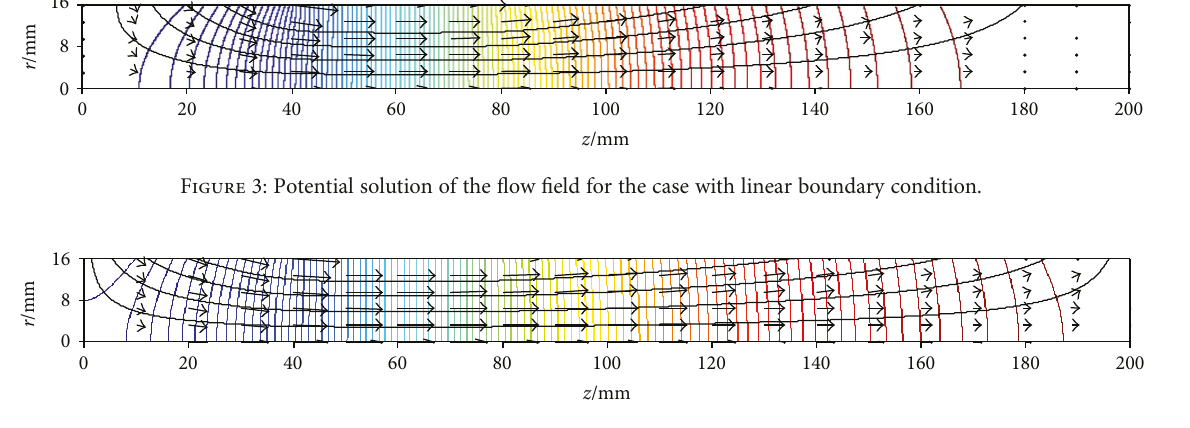
Figure 4: Potential solution of the fl ow fi eld for the case with uniform but asymmetric boundary stand for the contour line of the velocity potential. In the fi gure, sub fi gure (a) corresponds to the velocity fi eld of the liquid fi lm at the evaporator; sub fi gure (b) corresponds to the velocity fi eld of the liquid fi lm at the condenser section; sub fi gure (c) corresponds to the velocity fi eld of the vapor phase at the evaporator; and sub fi gure (d) corresponds to